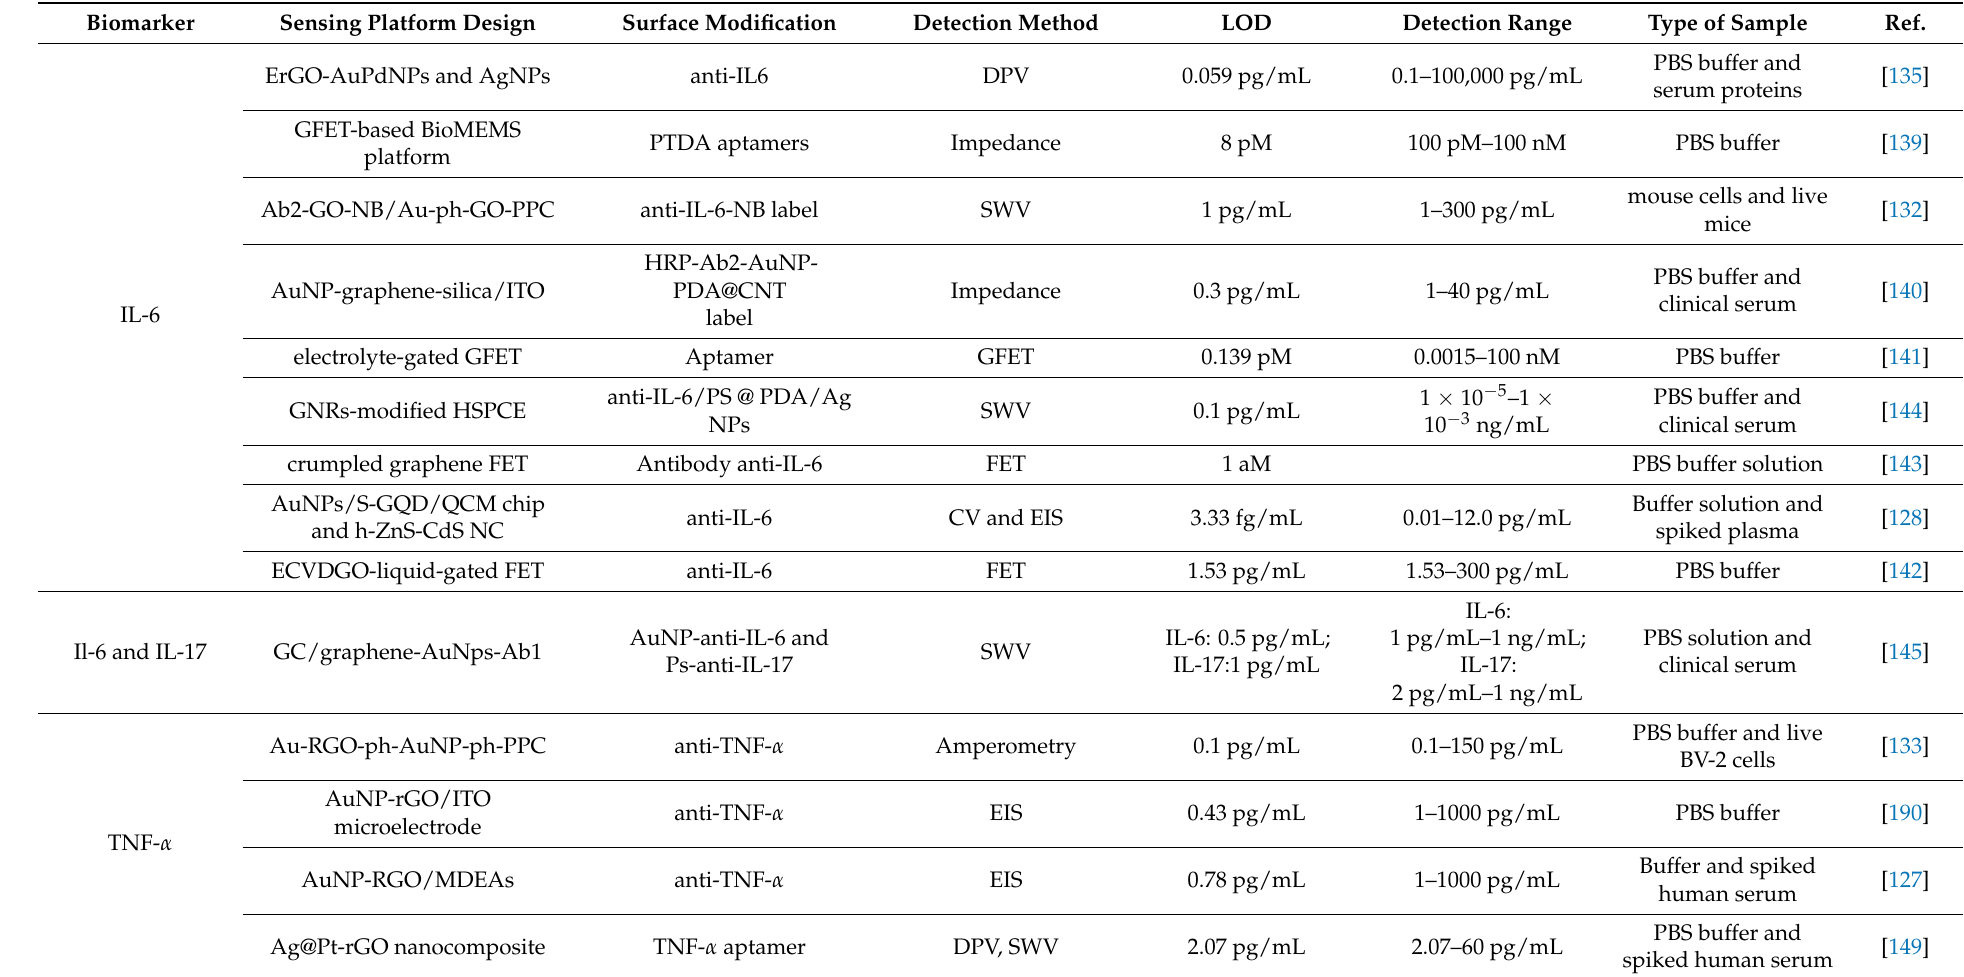
Table 2. Summary of electrochemical biosensors assisted with GDMs for detection of inflammatory disease